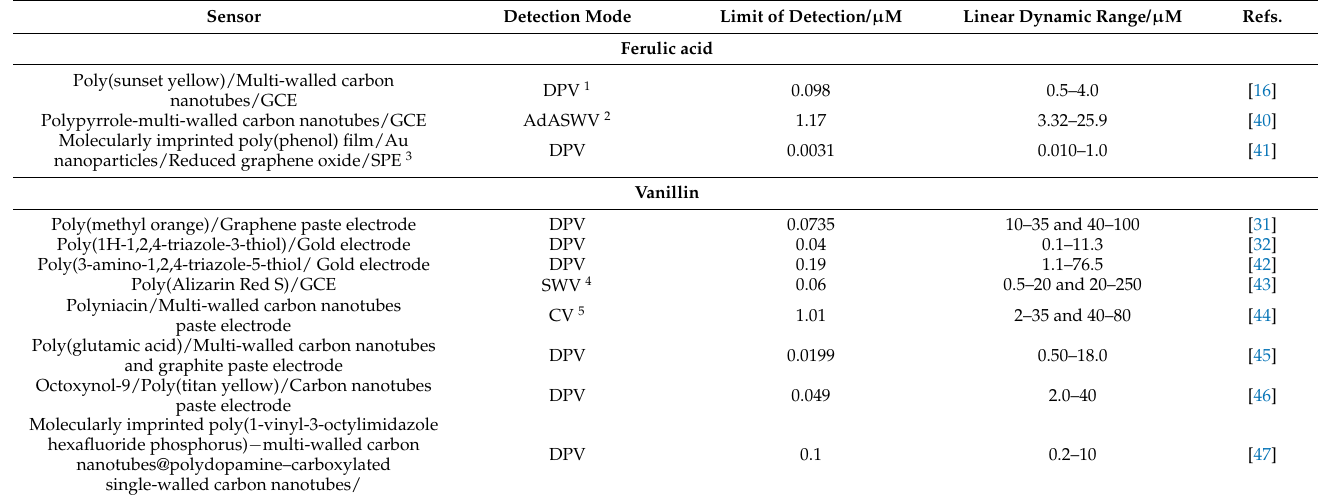
Table 3. Figures of merit for the electrochemical sensors based on the polymeric coverages for the individual determina- tion of ferulic acid and vanillin.